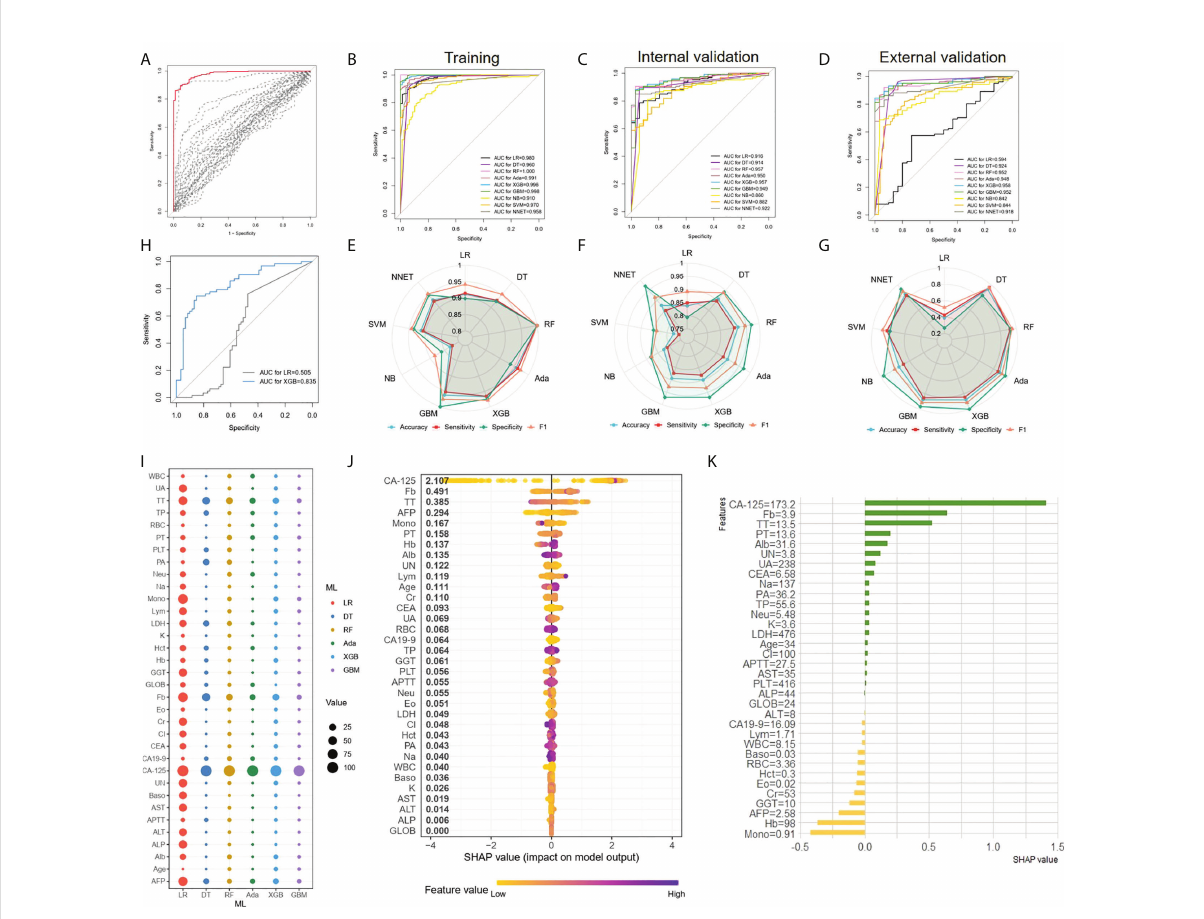
FIGURE 2 EOC diagnosis and ML models comparison (A) , ROC curves originated from multiple logistic regression for predicting EOC. The result of a multiple regression model using all 34 markers was indicated in the red line, whereas single regression results were represented by dashed lines. (B – D) Comparing the ROC curve of ML algorithms on the training set(B), the internal validation set (C) and the external validation set (D) (E – G) The accuracy, sensitivity, speci fi city and F1 of each model depicted by radar plot in the training dataset (E) , the internal validation dataset (F) and the external validation dataset (G) . (H) Comparison the AUC of XGBoost and LR in the diagnosis of negative CA-125 EOC patients. (I) , The relative importance ranking of variables for predicting EOC and benign diseases responses was calculated with LR, DT, RF, XGBoost and GBM. (J) , The XGBoost model showed great impact in predicting outcomes. (K) , The individual prediction result with SHAP